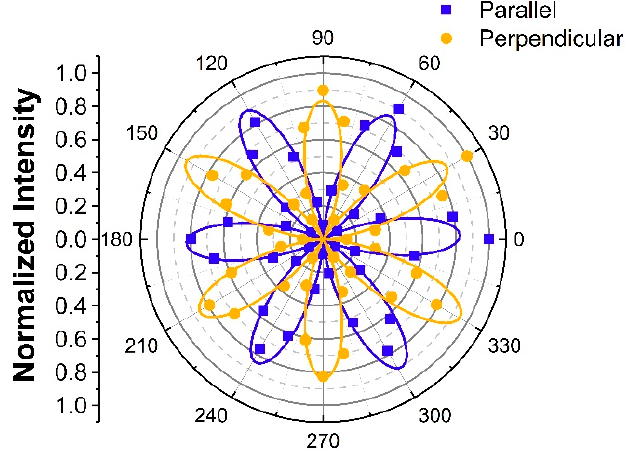
Figure 2. Normalized angle-resolved SHG patterns for SHG polarization parallel (blue squares) and perpendicular (orange dots) to the incident light polarization. The blue and orange solid lines are cos 2 3 θ and sin 2 3 θ curves, respectively.